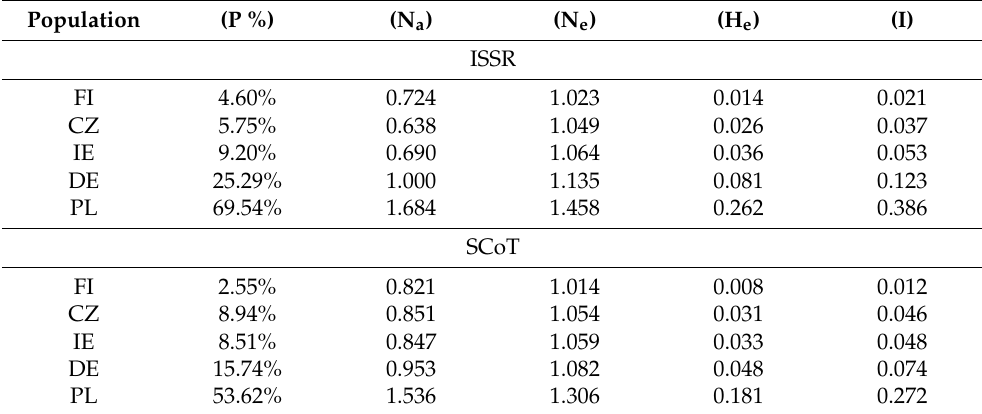
Table 5. The genetic variability parameters of B. graminis f. sp. avenae populations based on ISSR and SCoT markers. P %—percent of polymorphic loci; N a —number of alleles at the locus; N e —number of effective alleles at the locus; H e —expected heterozygosity; I—Shannon’s index.